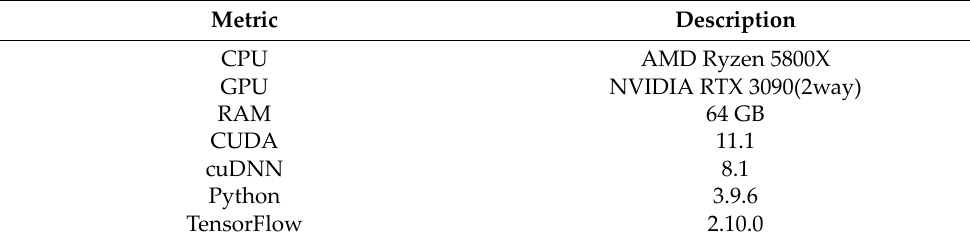
Table 2. Experimental specifications.